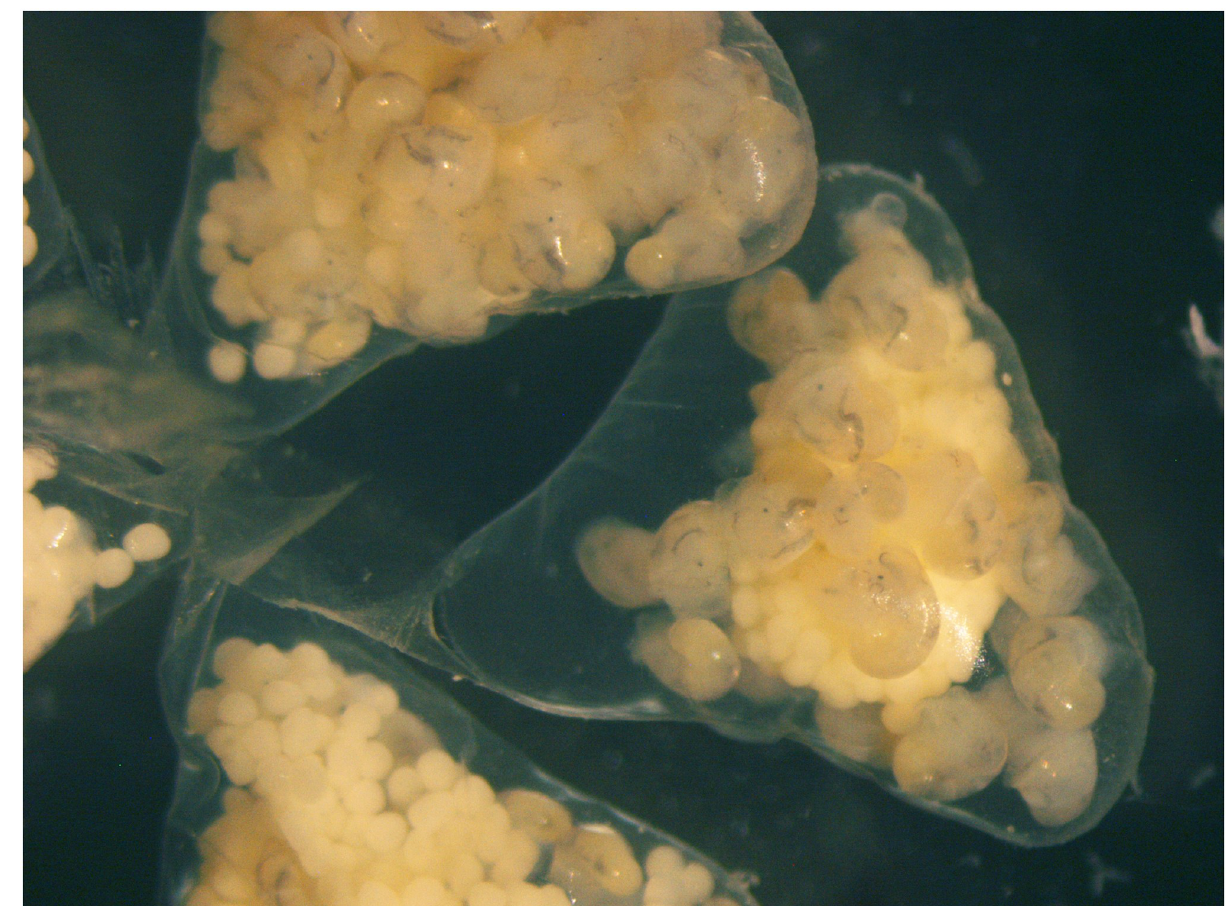
Fig 6. A group of stalked Crepipatella dilatata egg-capsules containing pediveligers and nurse